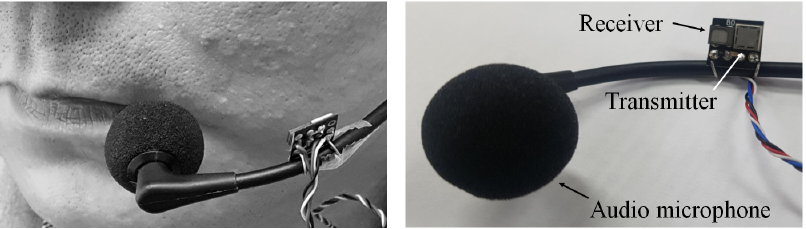
Figure 4. Photograph of the ultrasonic sensors. ( Left ): Mounted on the right cheek. ( Right ): Fig. 4. Photograph of the ultrasonic sensors. Left: Mounted on the right cheek. Right: Magnified Magnified sensor sensor portion.